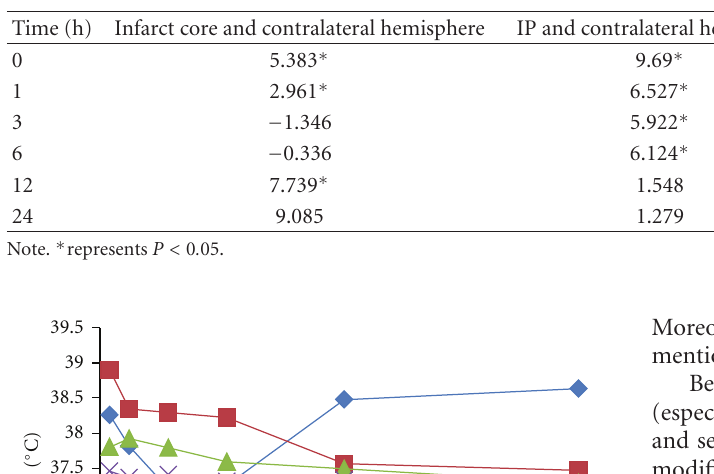
Table 3: Paired t -test of brain temperature between di ff erent ischemic tissues and contralateral hemisphere in monkey MCAO model ( t value).